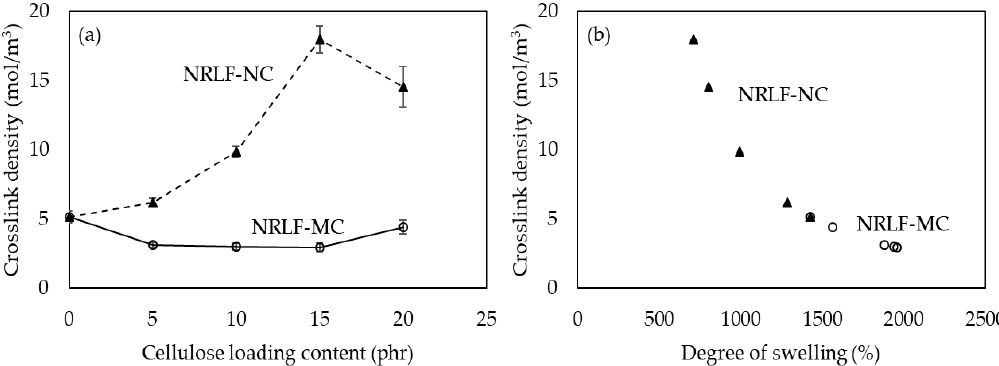
Figure 5. Crosslink density as a function of ( a ) cellulose loading content and ( b ) degree of swelling in toluene. The filled triangles and open circles are for NRLF-NCs and NRLF-MCs, respectively.